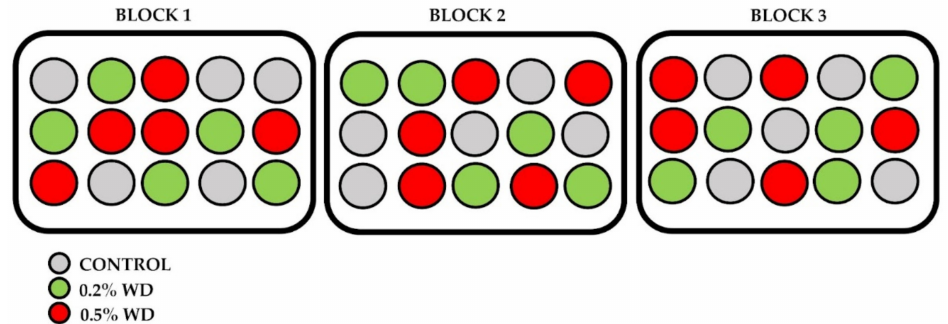
Figure 2. Organization of the 45 pots into three blocks containing 5 replicates per treatment each, inside the climatic chamber. Within each block, pots were mixed every three days. WD = Wood